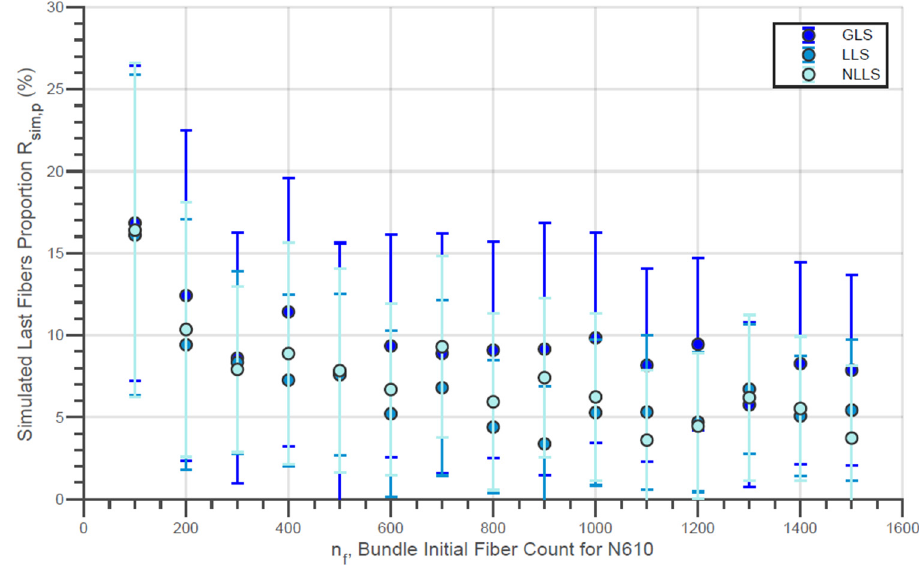
Figure 16. Simulated Last Fiber Proportion for Different Fiber Amounts for Virtual N610 Fiber Bundles.